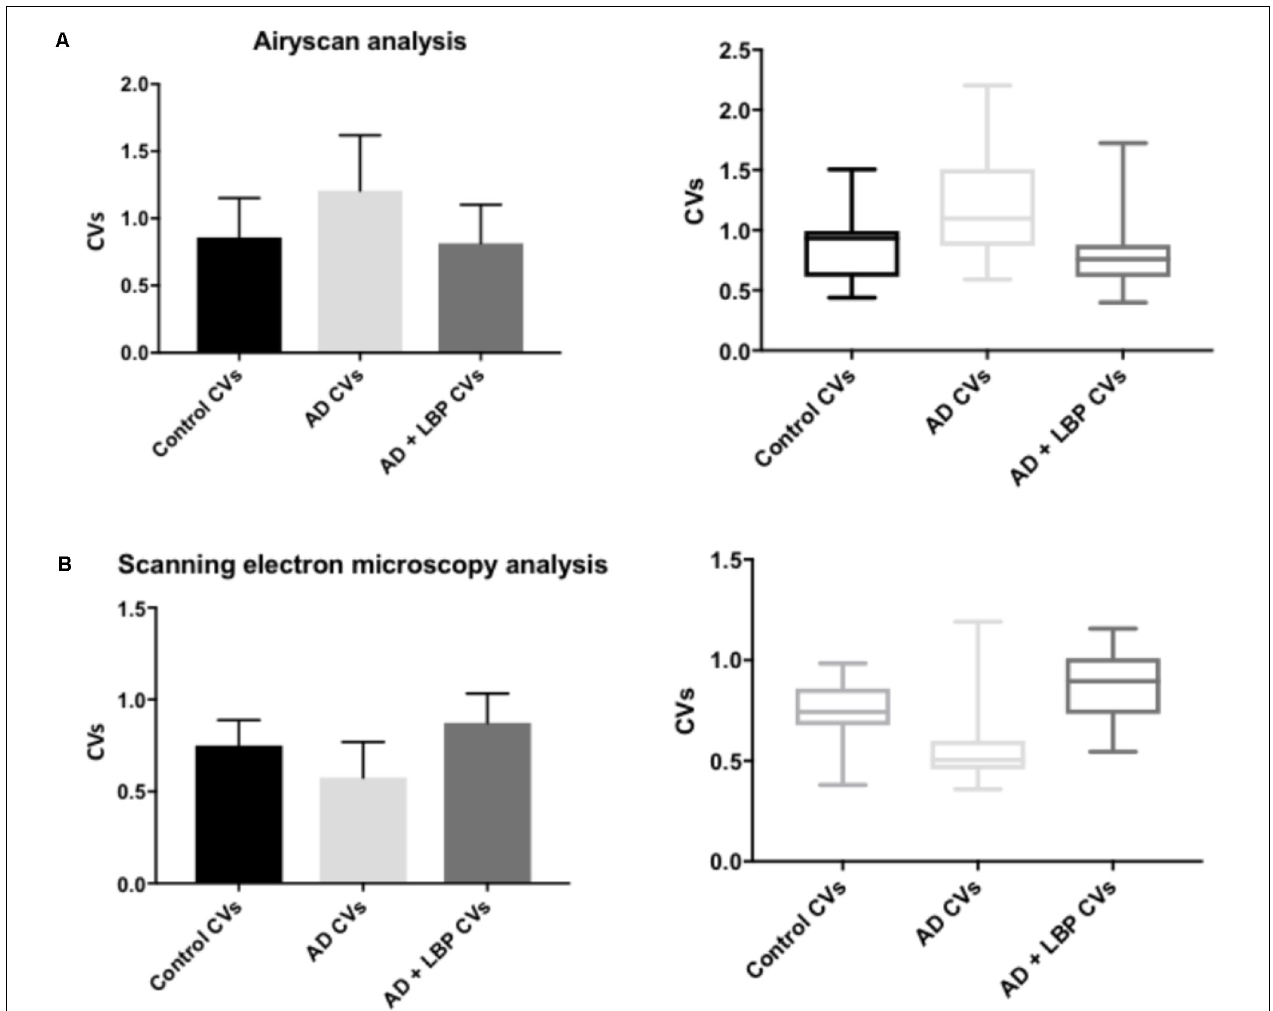
FIGURE 6 | Graphs and boxplots from coefficient of variation (CVs) form histogram data of Airyscan analysis (A) and SEM (B). Coefficients of variation (CV) of the intensity of the pixels in the clot images was done using the Tukey’s analysis. Control vs. AD and AD vs. AD + LBP significantly differ by < 0.0001. Control vs. AD + LBP are not significantly